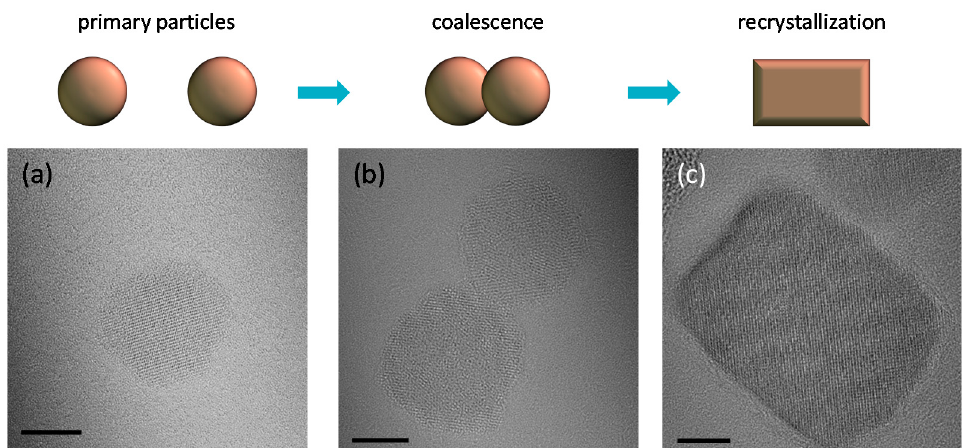
Figure 3. TEM micrographs and the corresponding scheme of growth from spherical primary particles (PPs) in sample 1 ( a ) by coalescence of PPs into secondary particles (SPs) in sample 2 ( b ) and their further recrystallization in sample 3 until rectangular and cubic shapes in sample 4 ( c ). All scale bars are 5 nm.